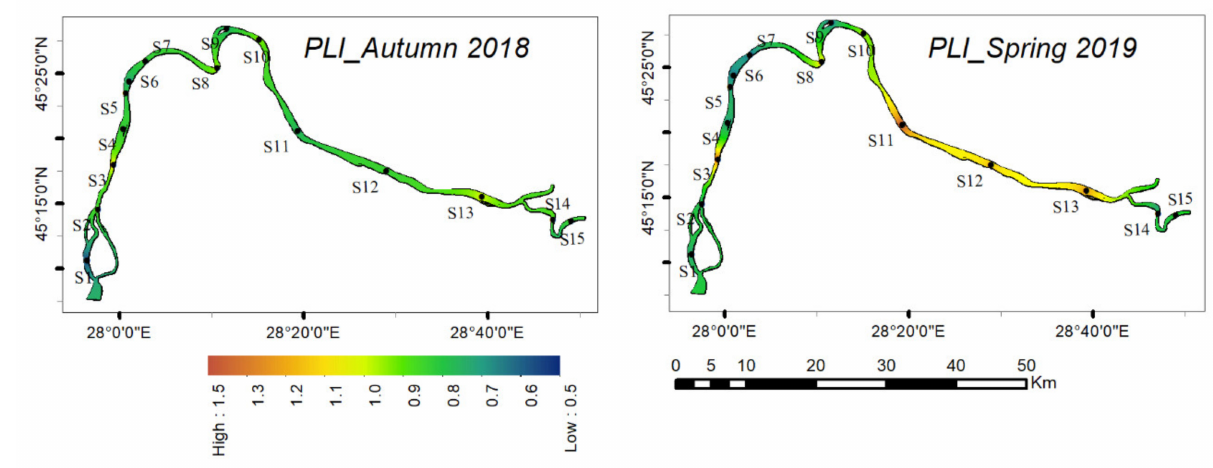
Figure 3. Spatial distribution of the PLI in the autumn of 2018 and the spring of 2019. The present study highlights the differences in heavy metal concentrations measured in surface sediments between the monitoring stations and the two seasons. In order to highlight the difference between the two seasons, Principal Component Analysis (PCA) was applied (Figure 4). Figure 4 displays a significantly different distribution between the two seasons of the obtained values, especially for the metals Cd, Cu, Ni and Zn. In contrast, there were no important seasonal variations in Pb concentrations. Moreover, from the PCA statistical analysis, it was observed that, for the heavy metals Cu, Ni, Zn and Cd, higher concentrations were registered during the spring season for most sediment